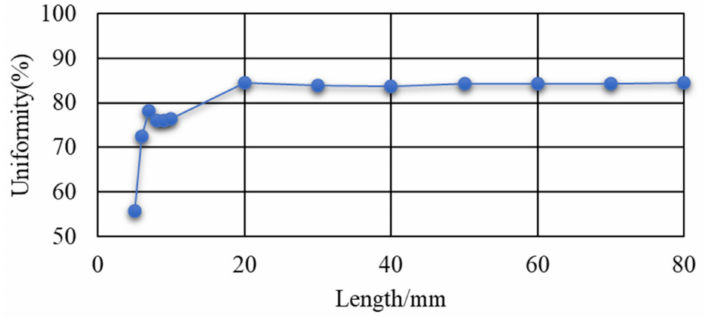
Figure 15. Variation curve of uniformity with the